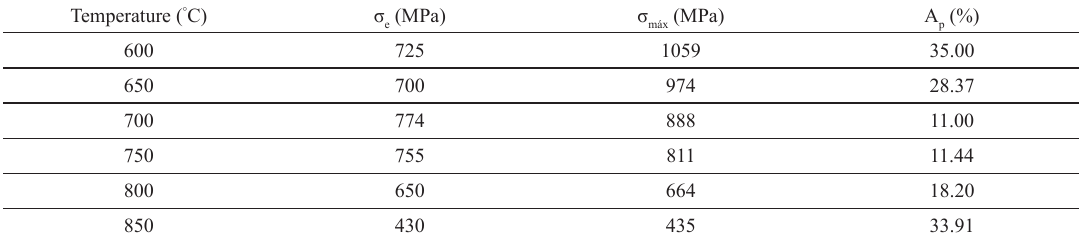
Table 1. Hot tensile test data of Inconel 718 superalloy as received. Temperature ( °